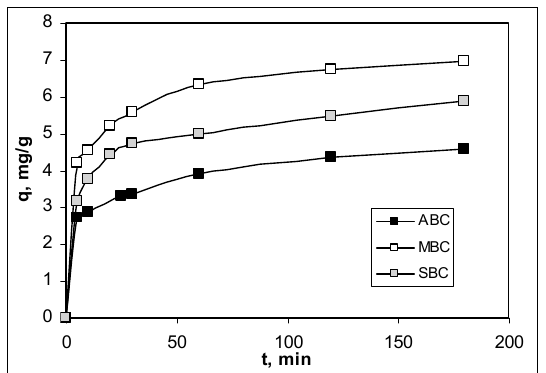
Figure 5. E ff ect of contact time on Co(II) sorption on the three types of biochars. (Experimental conditions: Initial pH = 5.0; biochar dose = 8 g / L; c 0 = 72 mg Co(II) / L; temperature = 25 ◦